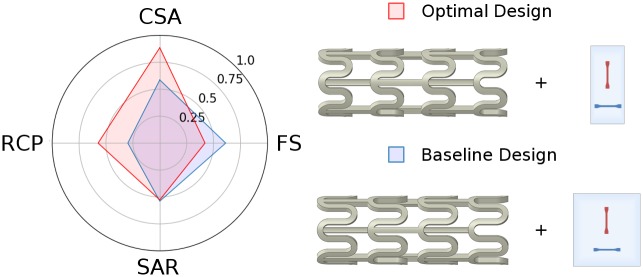
Visual comparison of normalised performance metrics and design parameters between the baseline design and the optimal design.